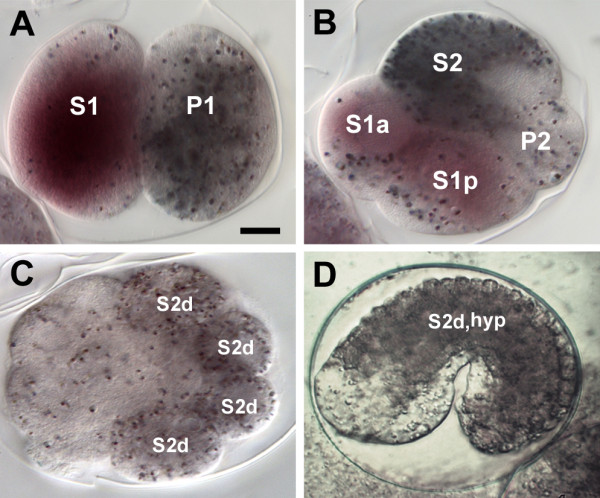
In situ hybridisation mapping of mex-3 mRNA distribution in early embryos of Romanomermis culicivorax. We used the R. culicivoraxmex-3 gene to prove application of the in situ technique in this species and investigated the segregation patterns of segregation of this maternal RNA in early development. The R. culicivoraxmex-3 expression pattern is similar to that of C. elegans[83]. R. culicivorax embryos contain dark pigment granules that are asymmetrically segregated in development. (A) At the 2-cell stage, maternal mex-3 mRNA is detected in the S1 blastomere. The cytoplasmic pigment granules are predominantly in the P1 blastomere. (B) At the 4-cell stage, mex-3 mRNA is detected in daughters of the anterior S1 cell. Cytoplasmic pigment granules are predominantly in the S2 blastomere. (C) At a later stage (>20 cells), mex-3 mRNA is absent. The pigment granules are found in descendants of S2 (S2d). (D) During early morphogenesis, the pigment granules are found in S2 descendants forming hypodermis, (S2d, hyp). (A-C) fixed embryos; (D) live embryo. Scale bar 10 μm. Orientation: anterior left.